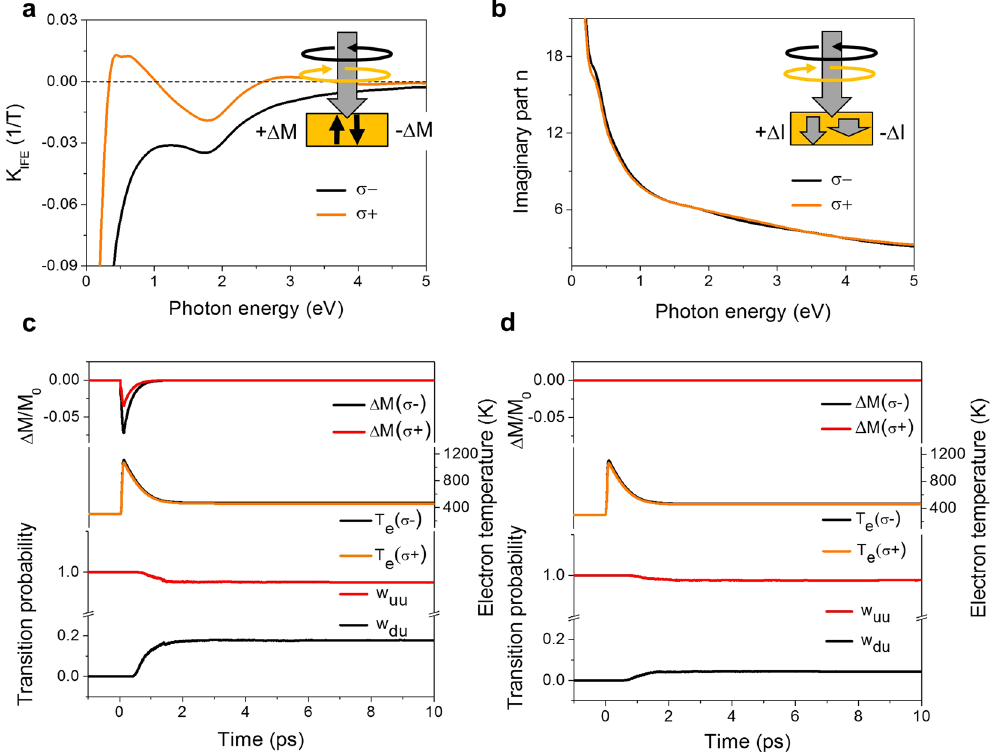
Figure 2. Ab initio calculations and switching probabilities. ( a ) The calculated inverse Faraday effect constant ω σ ± K ( ) of FePt for different photon energies ħ ω and helicities σ± . ( b ) Calculated imaginary part of the optical IFE constant n for different photon energies and helicities σ± . ( c , d ) Magnetisation switching in FePt, following a laser pulse triggering a sudden electron temperature rise with a peak electron temperature of about 1100 K but with a slight difference due to the MCD (i.e., T e ( σ± )) at 1.55 eV of about 32 K, a peak inverse Faraday effect with a decay time of the IFE induced magnetisation Δ M of − 7.1% and − 3.45% of the saturation magnetisation M S of 250 fs. The parameters serve as an input for our magnetisation dynamics calculations using the LLB equation of motion. These calculations result in switching probabilities from ‘down’ to ‘up’, w du , and ‘up’ to ‘up’, w uu , in c , taking into account both IFE and MCD contributions, and in ( d ) with the MCD only without IFE. The scenario corresponds to an average power onto the sample of 11 mW (9.6 mJ/cm 2 per